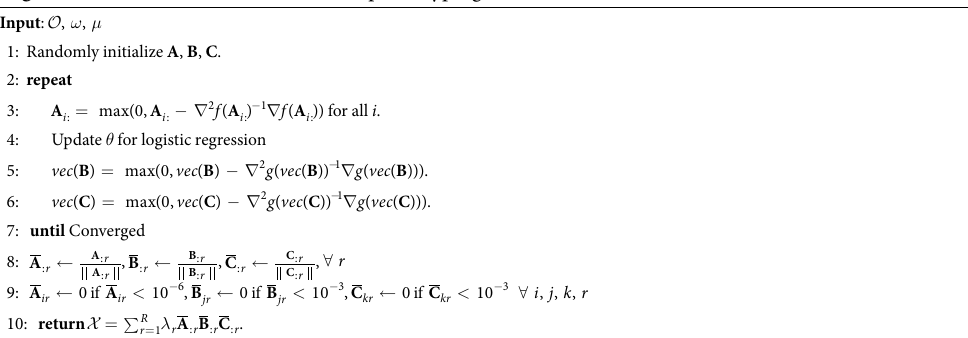
Algorithm 1 Discriminative and distinct